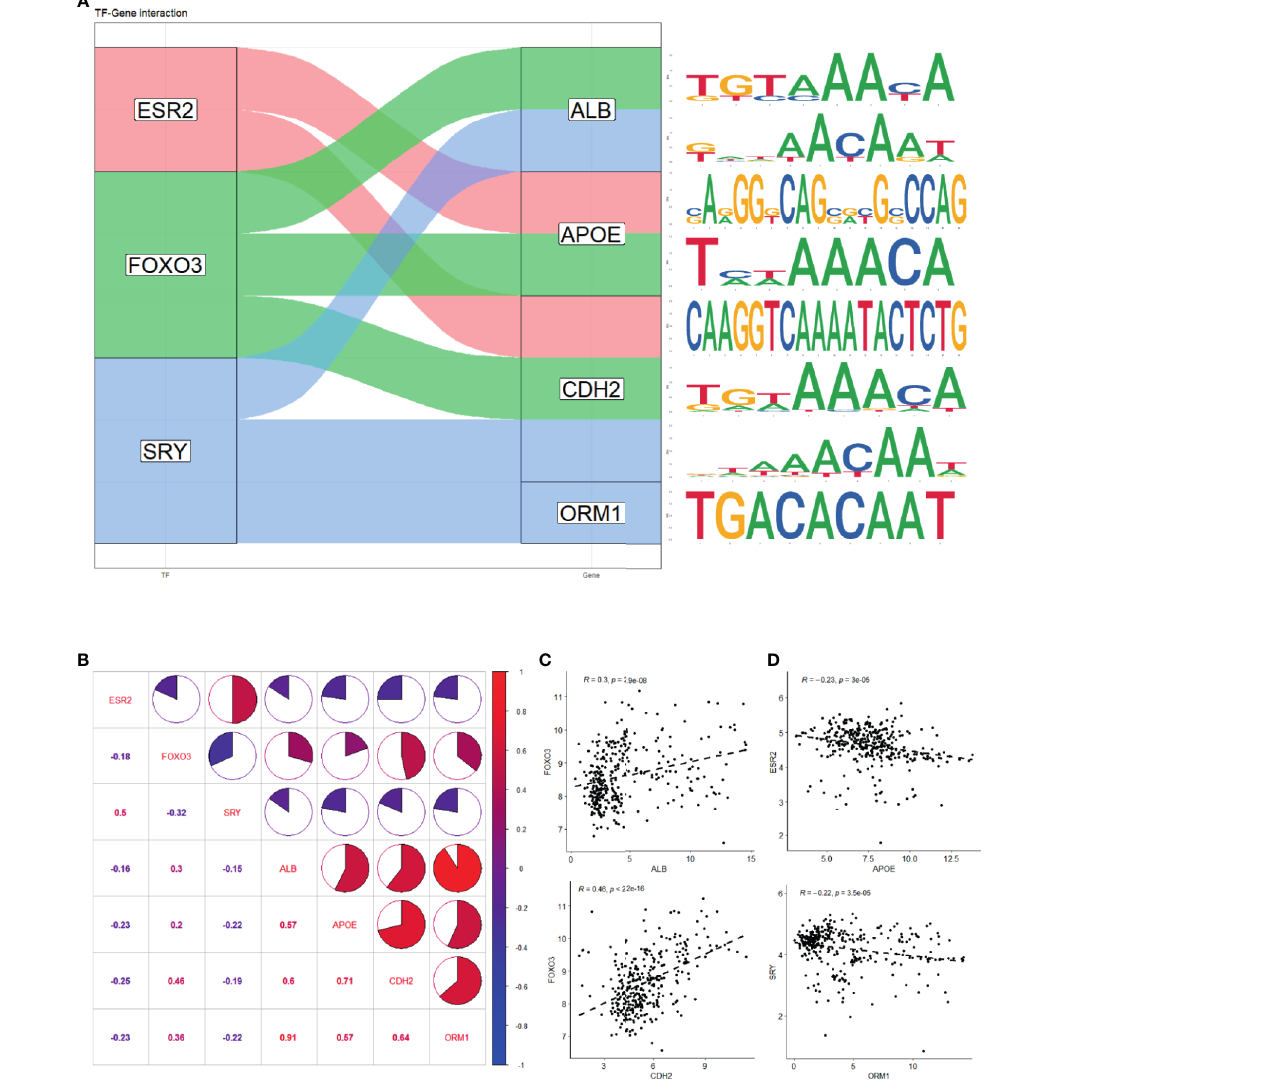
FIGURE 6 | Prediction of hub genes-related transcription factor. (A) Potential binding site of TF and genes predicted with oPOSSum 3.0. (B) Expression correlation of TF and genes in four GEO series. (C) Signi fi cant positive correlation between ALB and FOXO3 expression and CDH2 and FOXO3 expression. (D) Signi fi cant negative correlation between APOE and ESR2 expression and ORM1 and SRY expression. The statistical signi fi cance of correlations was determined using Pearson ’ s correlation coef fi